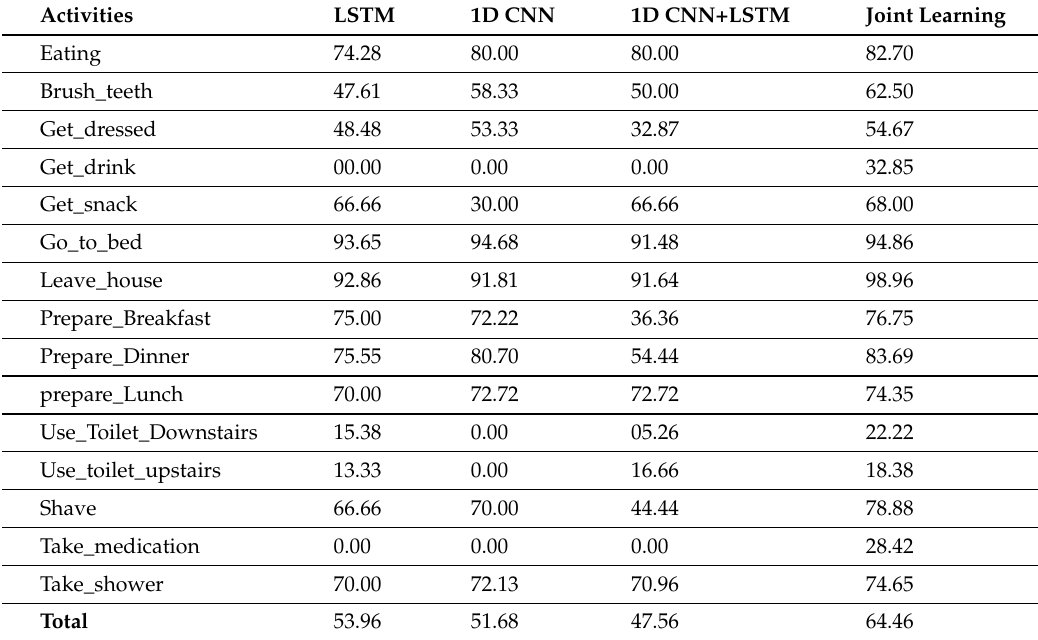
Table 6. F1-score results of Kasteren home C